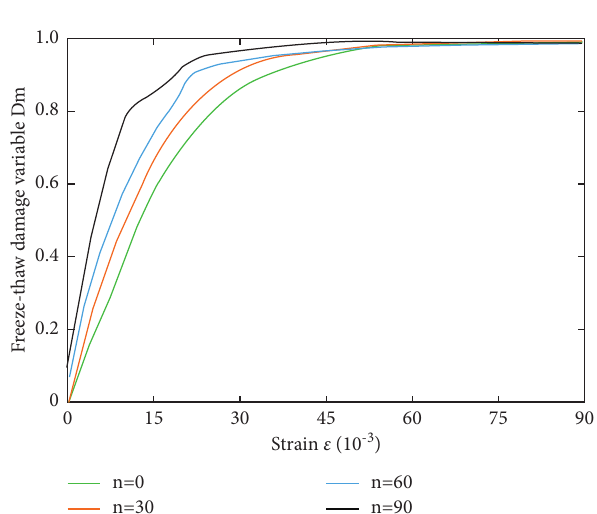
Figure 4: Damage curve of Yingan rock under freezing and thawing conditions.